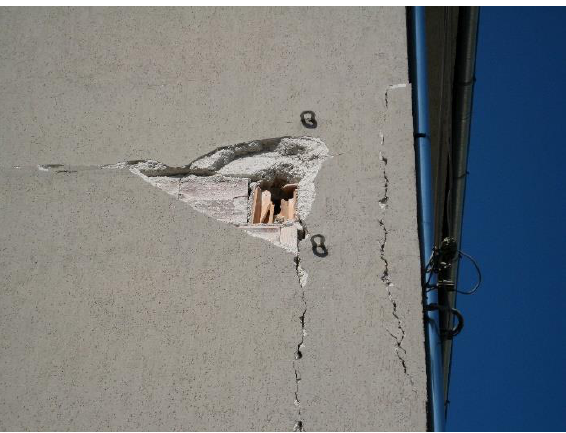
Figure 19. Damage on beam – column joints at the first story of the monitored structure (Municipal- ity of Navelli). More details in [3].